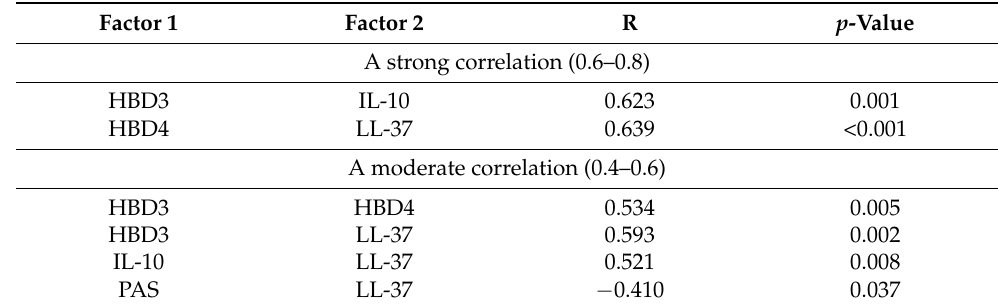
Table 5. Spearman’s rank correlation coefficient revealing correlations between different factors in tracheal hyaline